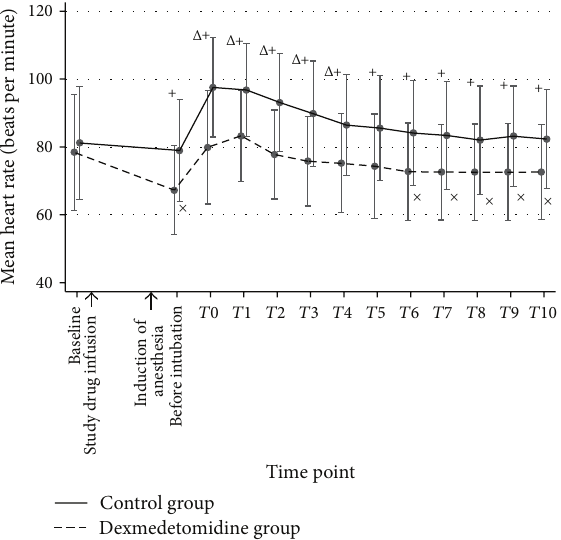
Figure 4: A line graph demonstrated the mean MAP and their stan- dard deviation comparing groups at different time points. Baseline refers to the point of time before the study drug is administered. Before intubation refers the point of time after anesthetic induction just before DLT intubation. T0 is the period during intubation. T1– T10 refer the points of time as minutes after intubation. MAP: mean arterial pressure. + P value < 0.05 compared between groups. Δ P value < 0.05, significant difference compared with baseline in the control group. × P value < 0.05, significant difference compared with baseline in the dexmedetomidine group.